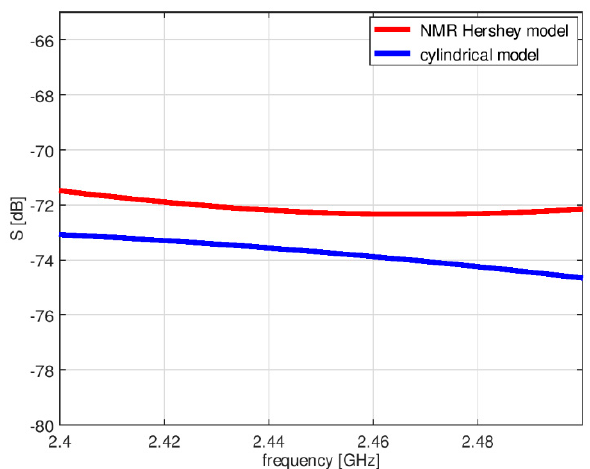
Figure 6. The system loss between the chest antenna (2) and leg antenna (3) (see Figure 4) obtained using the heterogeneous model and the simplified model.